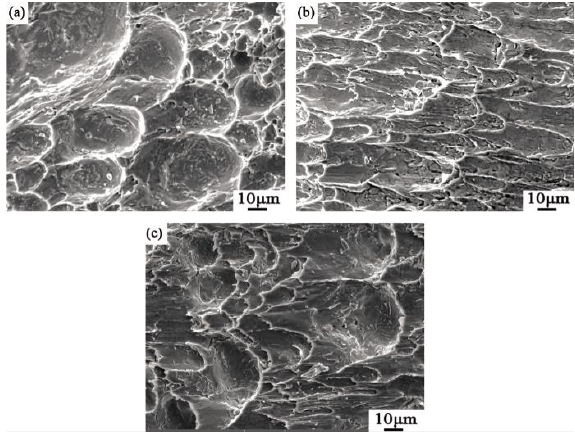
Figure 14. Shear fracture microstructure of Sn2.5Ag0.7Cu0.1RExNi/Cu solder joint under 300 thermal-cycle loading for different Ni content. ( a ) 0Ni; ( b ) 0.05Ni; ( c ) 0.5Ni.